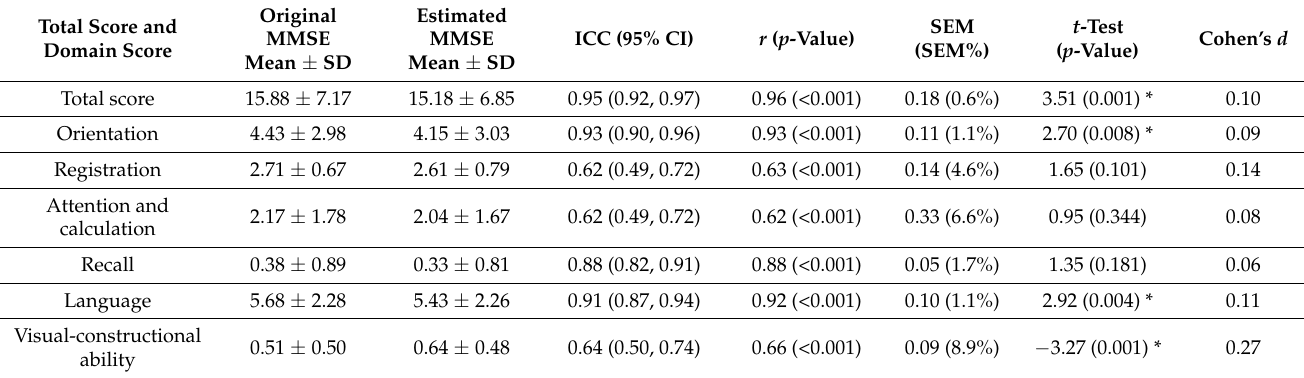
Table 2. Equivalence between the original and estimated MMSE (n = 110).